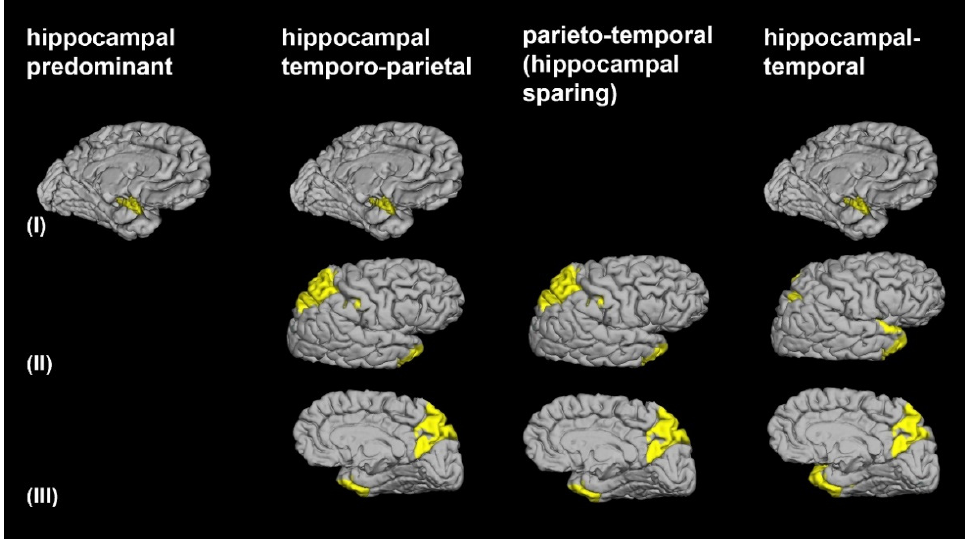
Figure 1. Morphometric patterns of gray matter atrophy. These subtypes were revealed at the four-cluster level, consisting of the brain regions identified by the principal component analysis, marked in yellow, such as ( I ) the hippocampus including the subiculum, the CA3, the CA4/dentate gyrus and the CA1-2 transition zones, ( II ) the superior parietal lobule, the precuneus, the cingulate sulcus marginal branch, the intraparietal sulcus and transverse parietal sulci, and the postcentral sulcus, ( III ) the superior temporal gyrus planum polare, the temporal pole, the inferior segment of the circular sulcus of the insula and the anterior transverse collateral sulcus. For cases with the bihemispheric presence of the brain region, the value of the side with the lower z-score is presented.